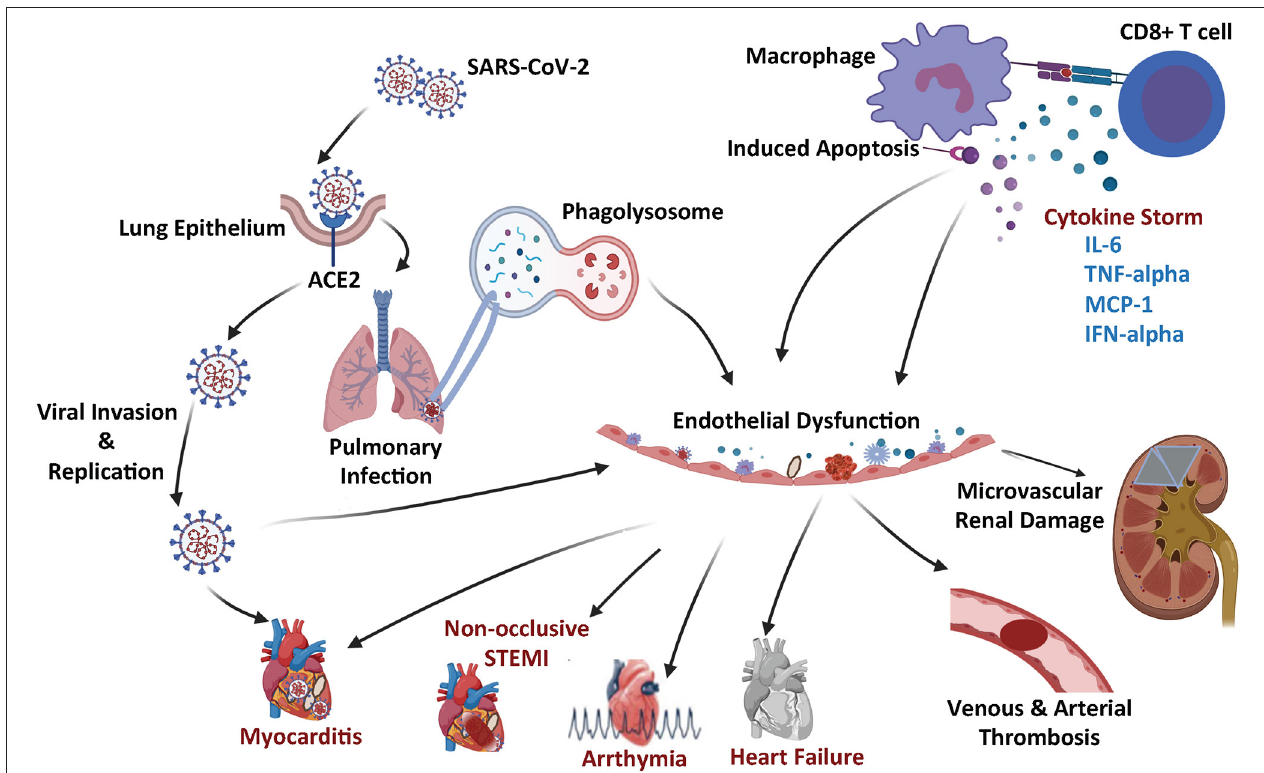
FIGURE 1 | Schematic summary of the COVID-19 microangiopathic consequences leading to myocarditis, non-occlusive STEMI, arrhythmia, heart failure, vascular thrombosis, and microvascular renal dysfunction.